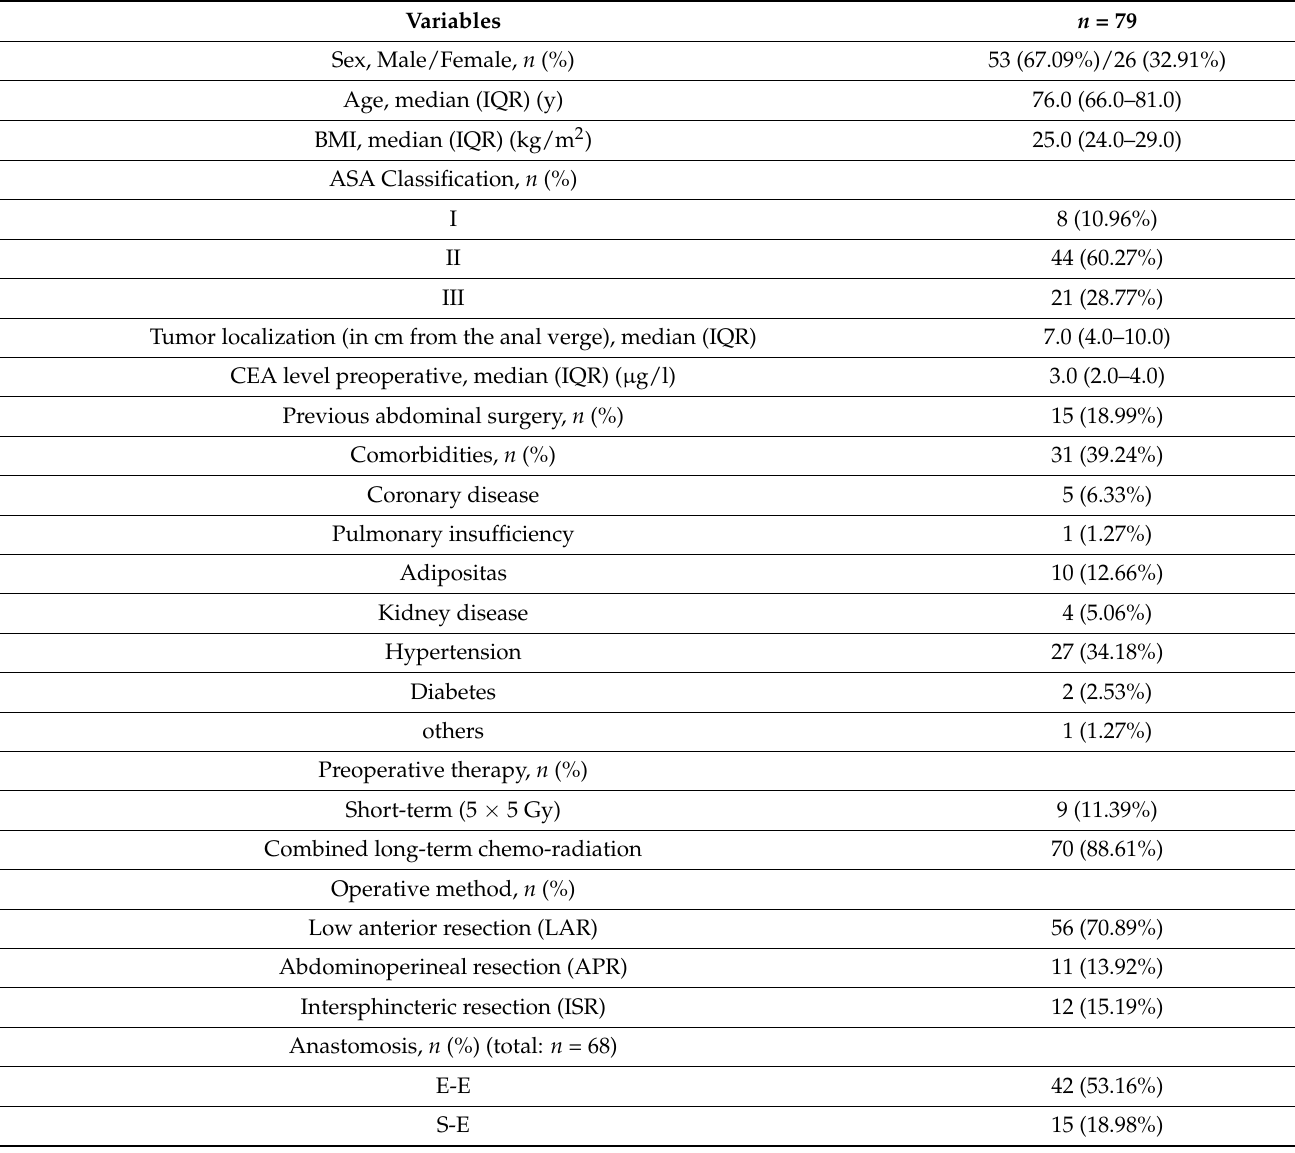
Table 1. Patient characteristics perioperative findings of included